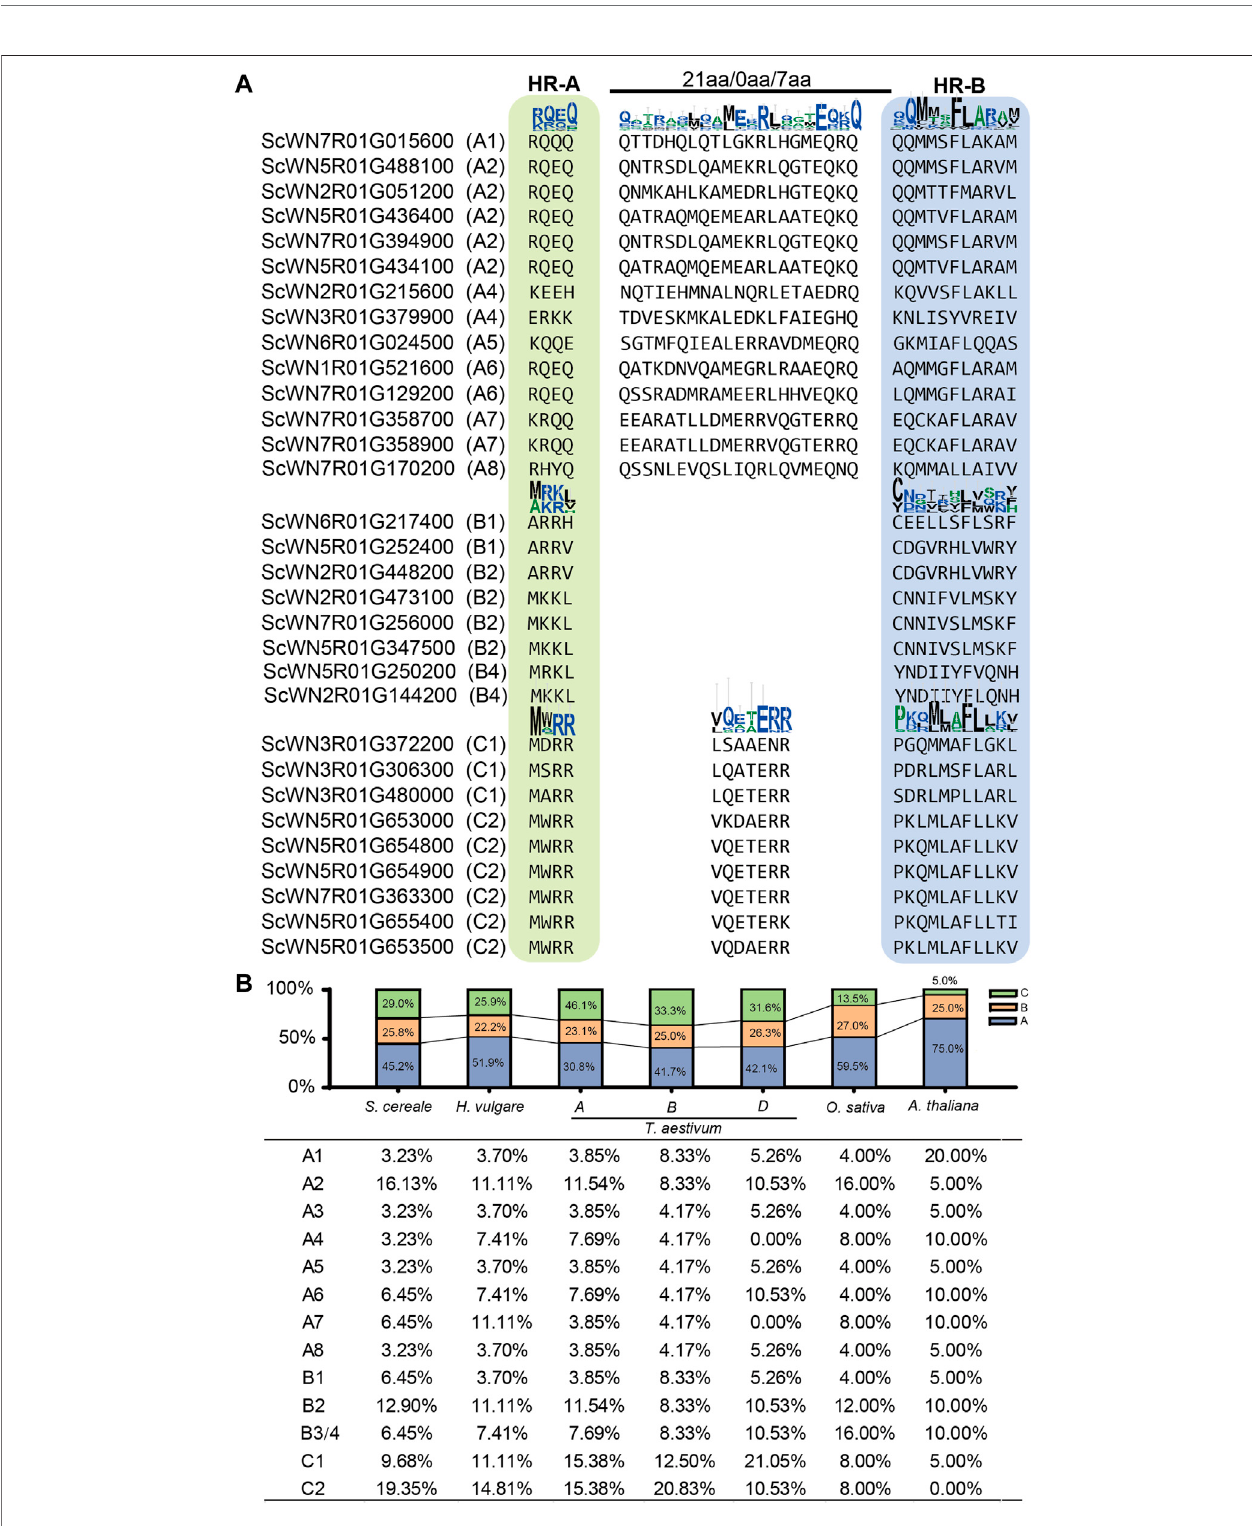
FIGURE 2 | Class and subclass division of S. cereale HSF genes. (A) . Classi fi cation of HSF genes in S. cereale based on protein sequence characteristics. (B) . Proportion of different classes and subclasses of HSF genes in S. cereale , H. vulgare , T. aestivum (three subgenomes), O. sativa and A. thaliana respectively.